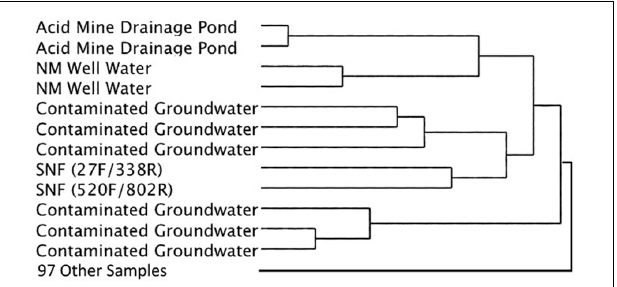
FIGURE 5 | Simplified dendrogram showing hierarchical cluster analysis by the Ward’s minimum variance method using RDP taxonomic